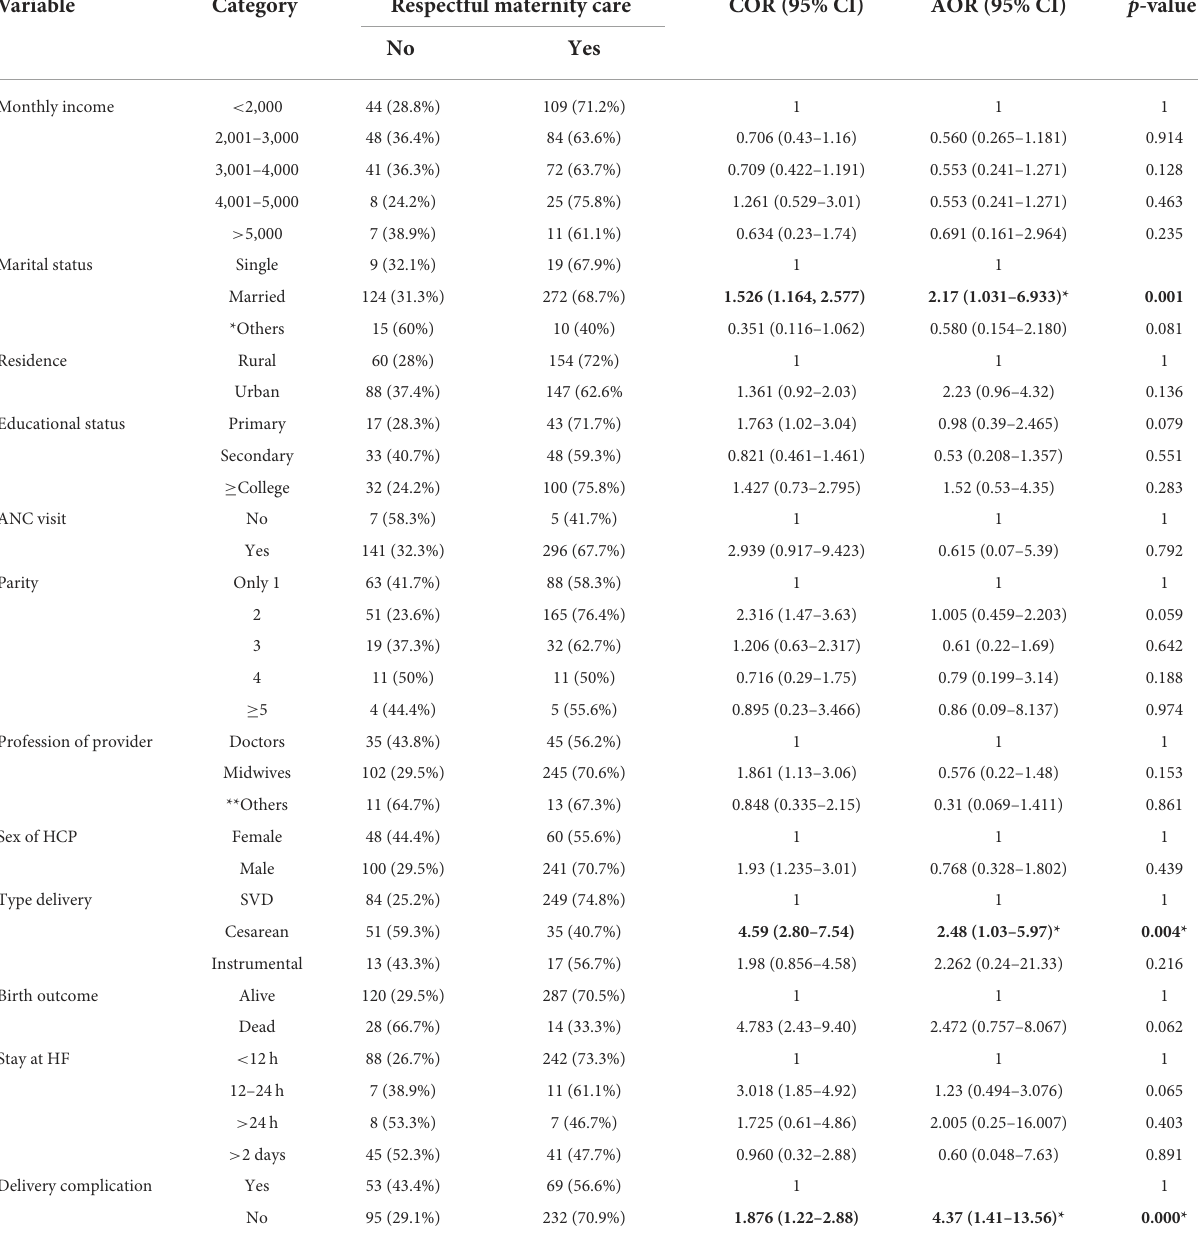
TABLE 4 Factors associated with respectful maternity care among mothers who gave birth at public hospitals of Hadiya Zone, southern, Ethiopia 2020 ( n =